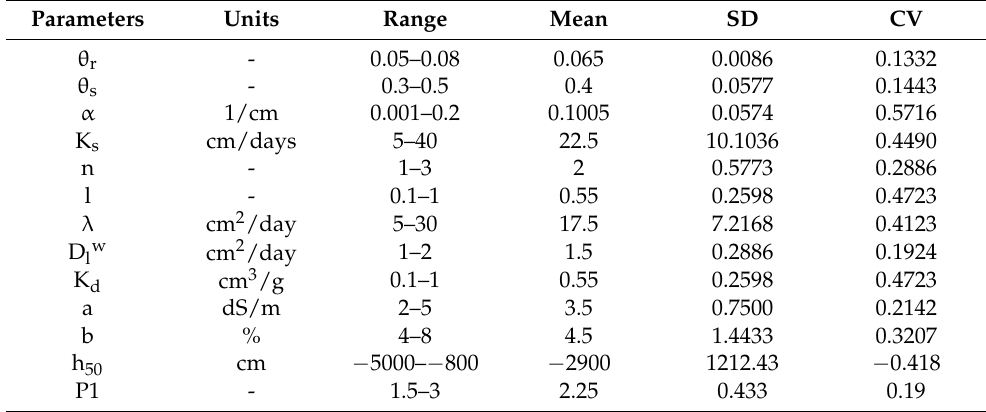
Table 4. The prior distribution of the parameters used in the HYDRUS-1D.